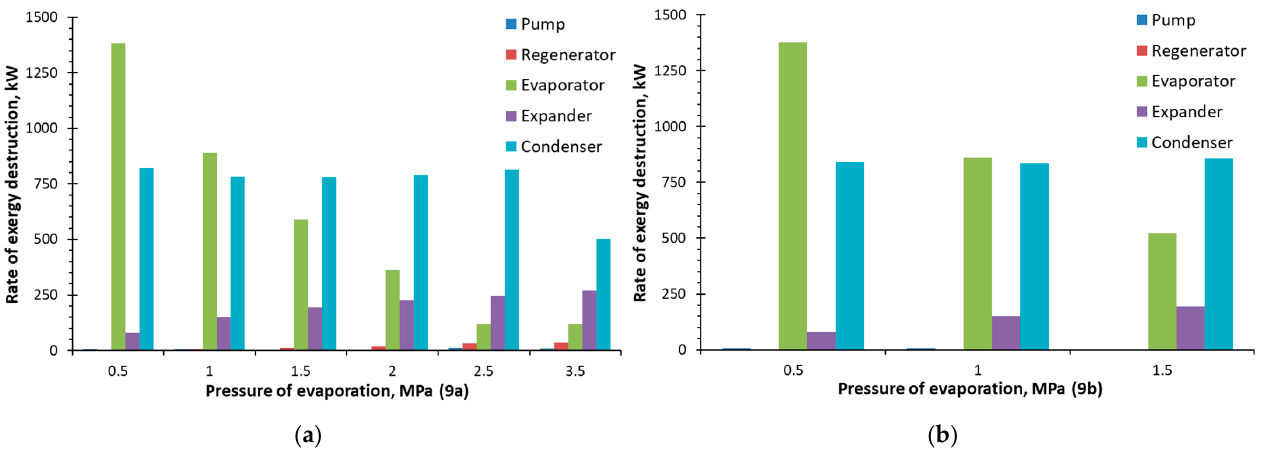
Figure 8. Rate of exergy destruction in the ORC cycle equipment using cyclopentane: ( a ) with regeneration, and ( b ) without regeneration.